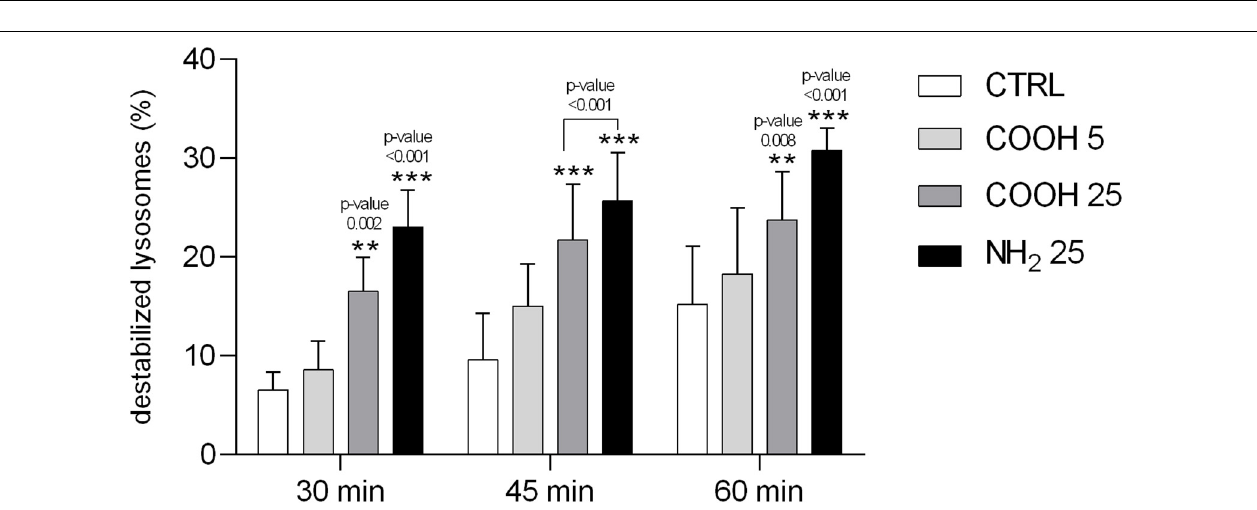
FIGURE 3 | Lysosomal membrane stability of sea urchin coelomocytes. Percentage of destabilized lysosomes scored in 100 P. lividus coelomocytes after 4 h of exposure to PS-COOH (5 and 25 µ g mL − 1 ) and PS-NH 2 (25 µ g mL − 1 ). Data are reported as mean ± SD ( n = 6, One-way, Tukey’s post-test, ** p < 0.01, *** p < 0.001). Asterisks indicate significant differences with respect to control and PS-COOH (5 µ g mL − 1 ) exposure